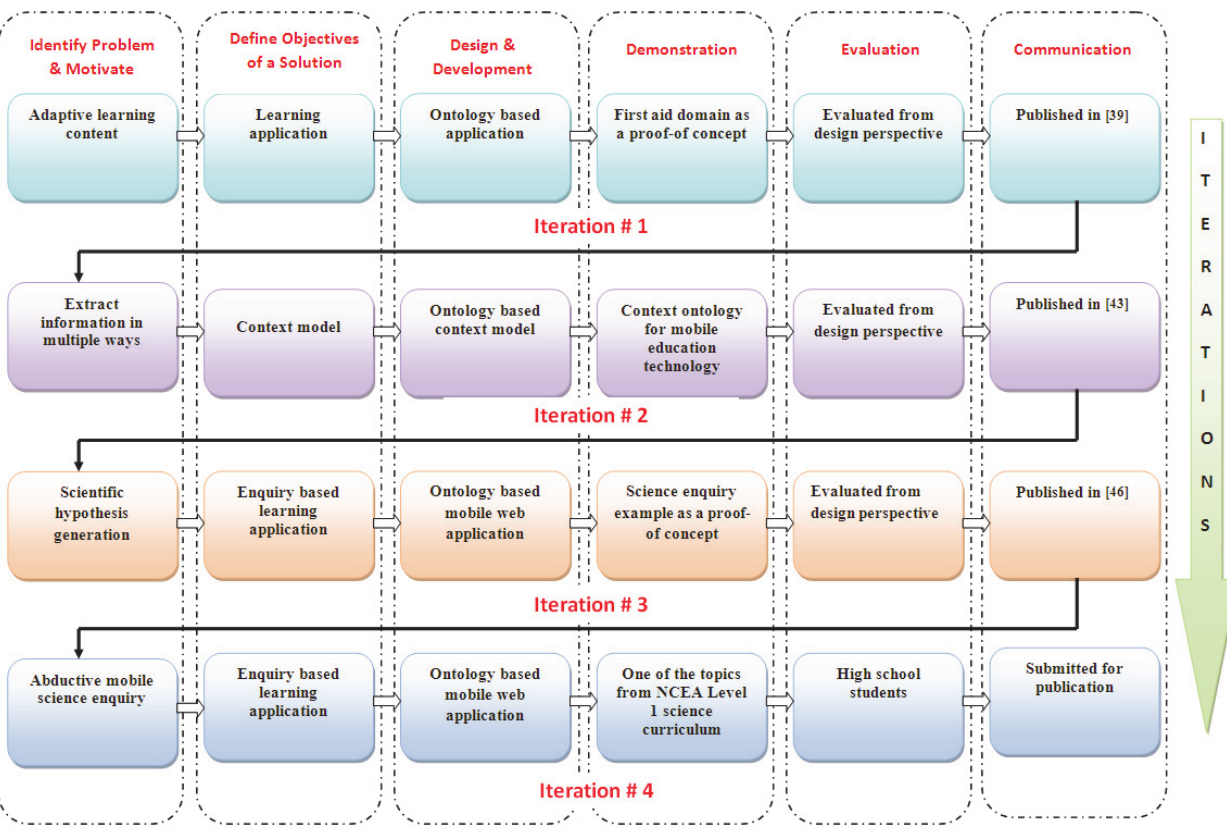
Figure 1. Research design iterations, adapted from